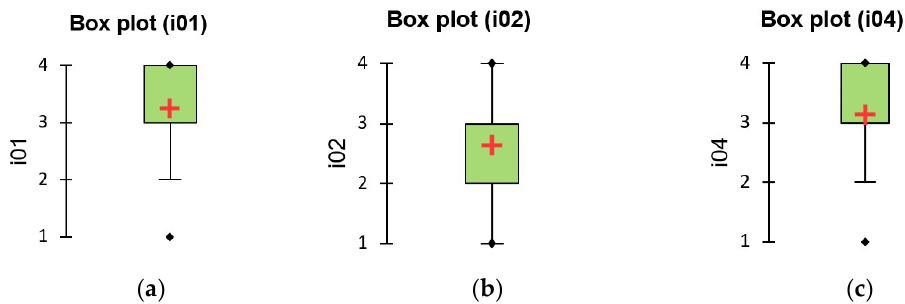
Figure 2. The most notable box plots: contact, descriptors, and typology. ( a ) (i01 contact); ( b ) (i02 descriptors); ( c ) (i04